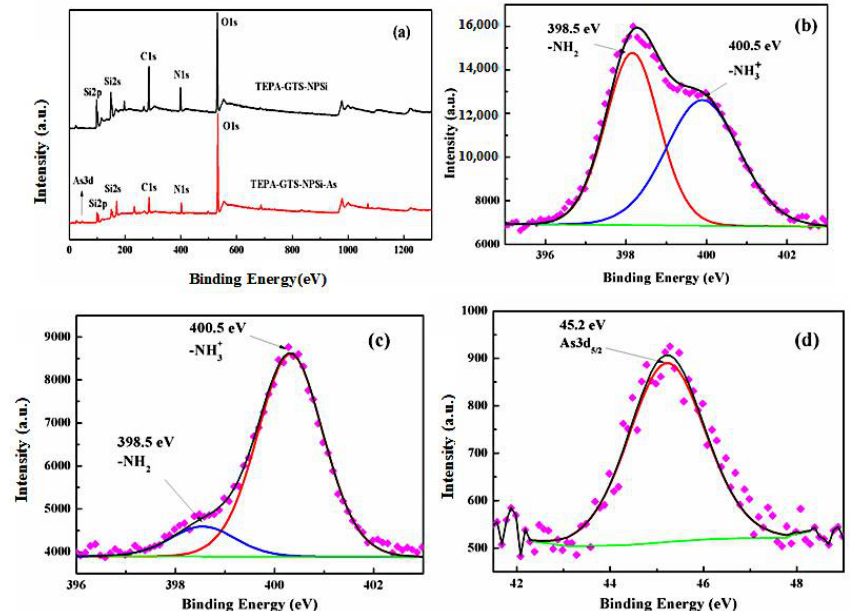
Figure 6. XPS analysis of before and after adsorption: ( a ) Wide-scan spectra of TEPA-GTS-NPSi before and after adsorption; ( b ) N1s spectra of TEPA-GTS-NPSi; ( c ) N1s spectra of TEPA-GTS-NPSi after adsorption; ( d ) As3d spectra of TEPA-GTS-NPSi after adsorption.